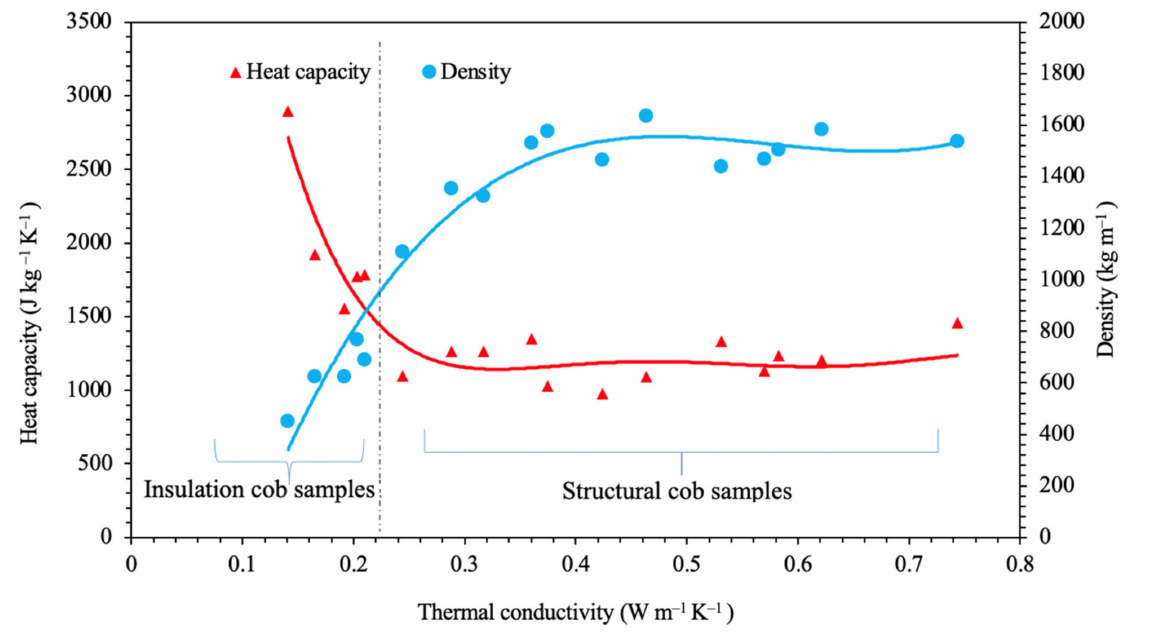
Figure 11. Density and heat capacity of the cob samples versus thermal